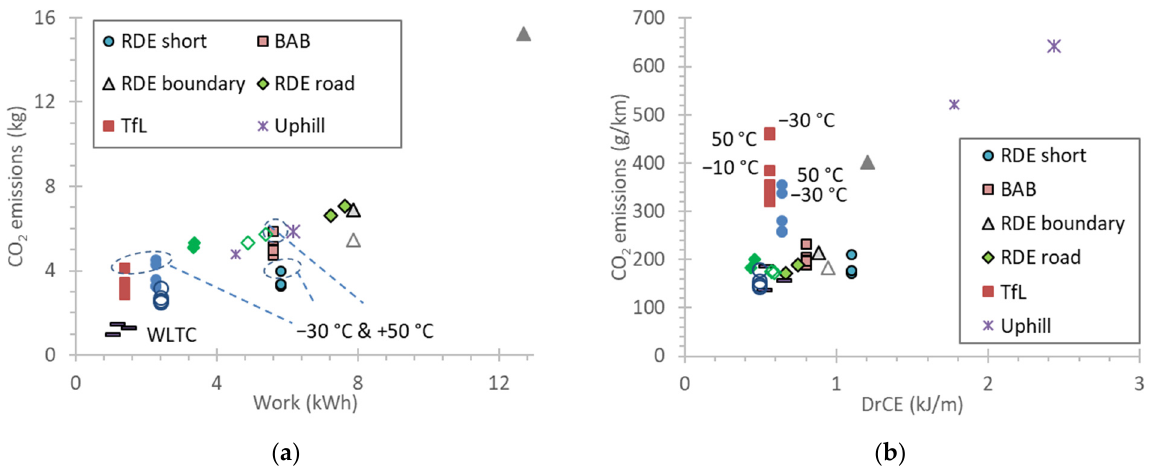
Figure 6. ( a ) Cumulative CO 2 emissions in function of positive work at the wheels; ( b ) CO 2 emissions in function of the distance related cycle energy (DrCE). Solid symbols are the urban cycles; open symbols are the rural cycles; symbols with frame are the motorway cycles. For RDE short, BAB, and TfL, there are five points for the five tested temperatures ( − 30 °C to 50 °C). The ambient temperatures of the tests that are further away from the rest points are indicated in the graphs.